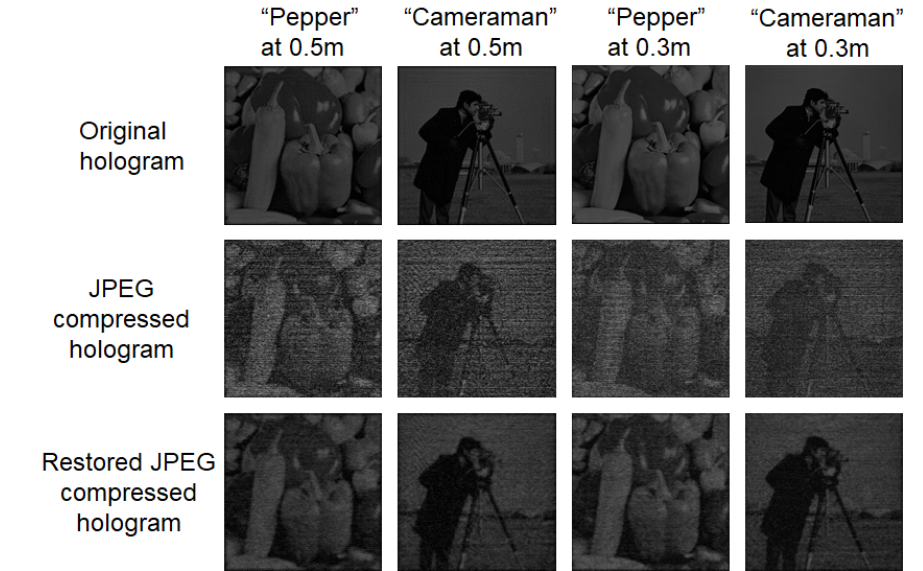
Figure 8. Reconstructed images from original holograms, JPEG compressed holograms and restored holograms in numerical